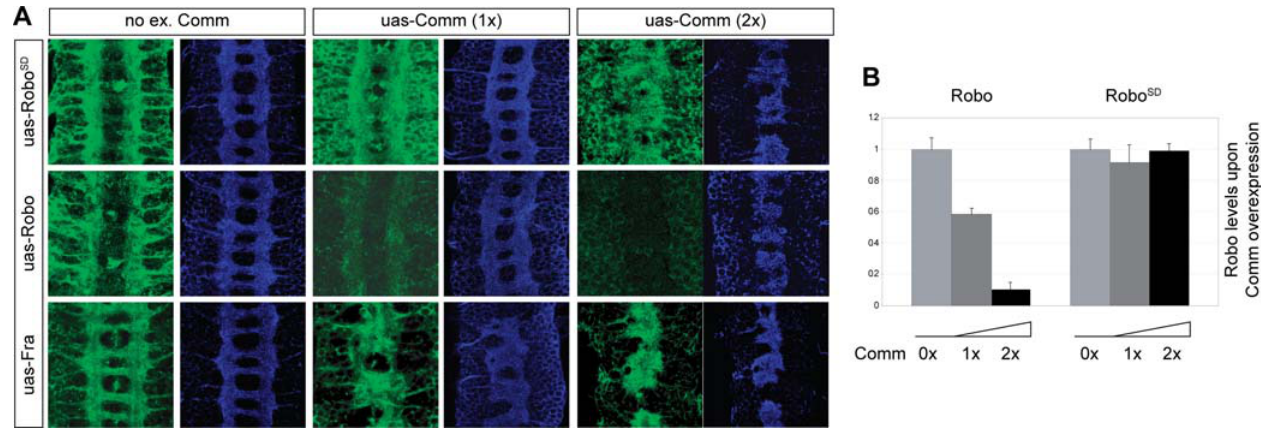
Figure 7. Overexpression of Comm induces a Slit phenocopy without reducing the amount of Robo SD . (A) CNS phenotype of embryos expressing none, one, or two copies of a Comm transgene using the GAL4-UAS system. Detectable levels of ectopically expressed HA-Robo drop proportionally to the amount of Comm expressed while HA-Fra, and HA-Robo SD do not show any reduction. In all cases overexpression of Comm induces a Slit phenocopy. anti-HA staining (Robo, Robo SD or Fra) is shown in green. anti-HRP staining (pan-neuronal marker) is shown in blue. (B) Quantification of detected protein levels of the experiment in (A).